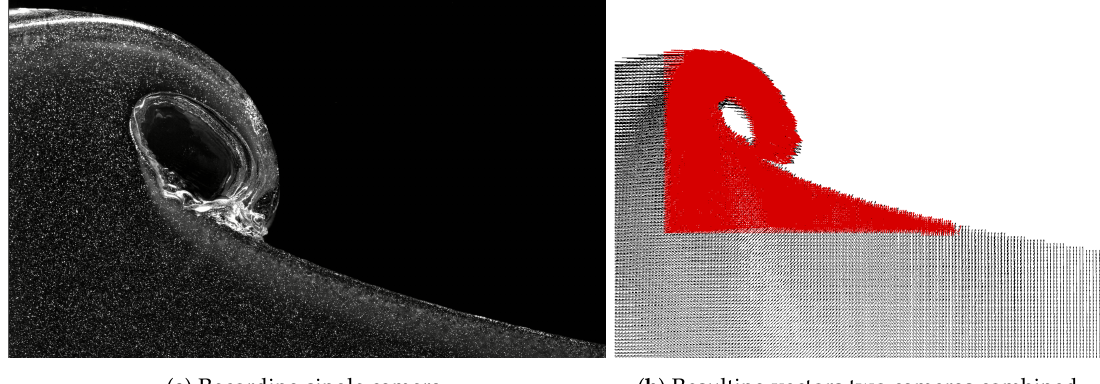
Figure 14. Example of PIV recording.